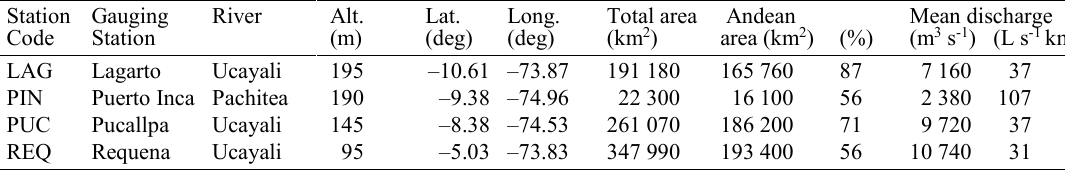
Table 1 Characteristics of river gauge stations in Ucayali River basin.